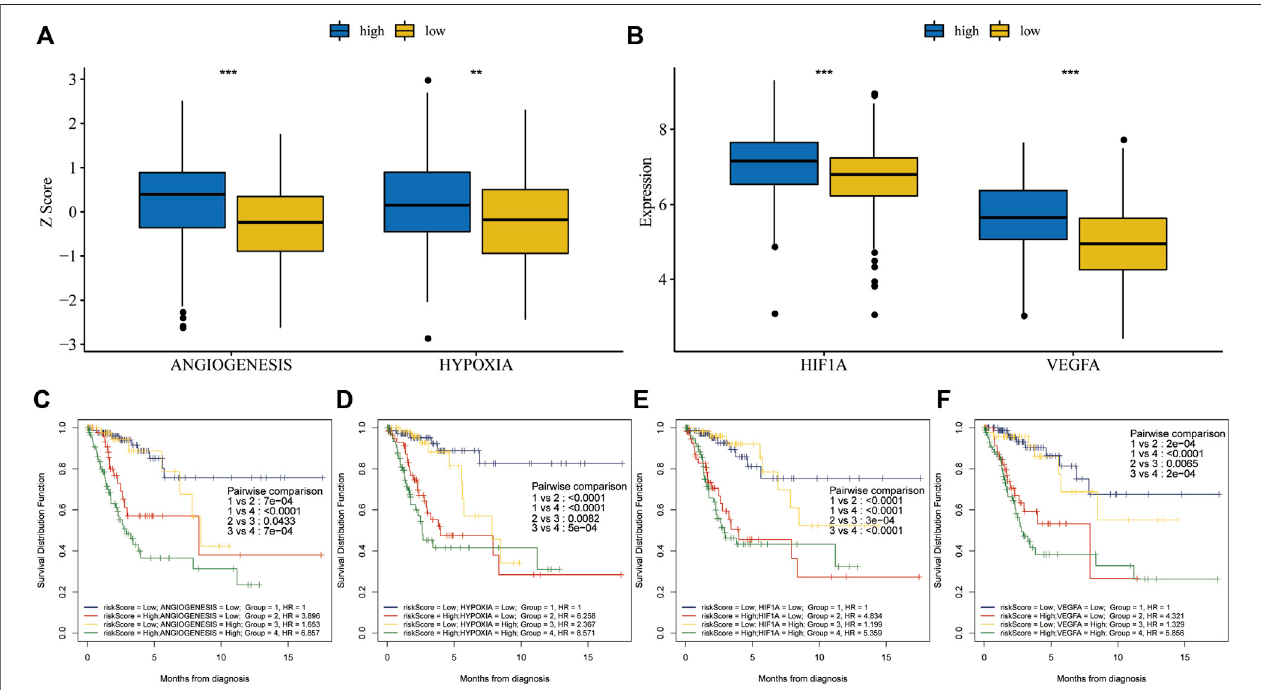
FIGURE8 | Combined survival analysis ofrisk scoresand keycancerhallmarks in the training set. (A) Hypoxia and angiogenesis z-scores were signi fi cantly higher in the high-risk group. (B) HIF1A and VEGFA expression levels were signi fi cantly higher in the high-risk group. (C,D) The prognosis was worse in patients with high risk scores and high hypoxia or angiogenesis z-scores, according to KM analysis for OS after combining risk scores and key cancer hallmarks. (E,F) The prognosis was worse in patients with high risk scores and high HIF1A or VEGFA expression, based on KM analysis for OS after combining risk scores and genes related to key cancer